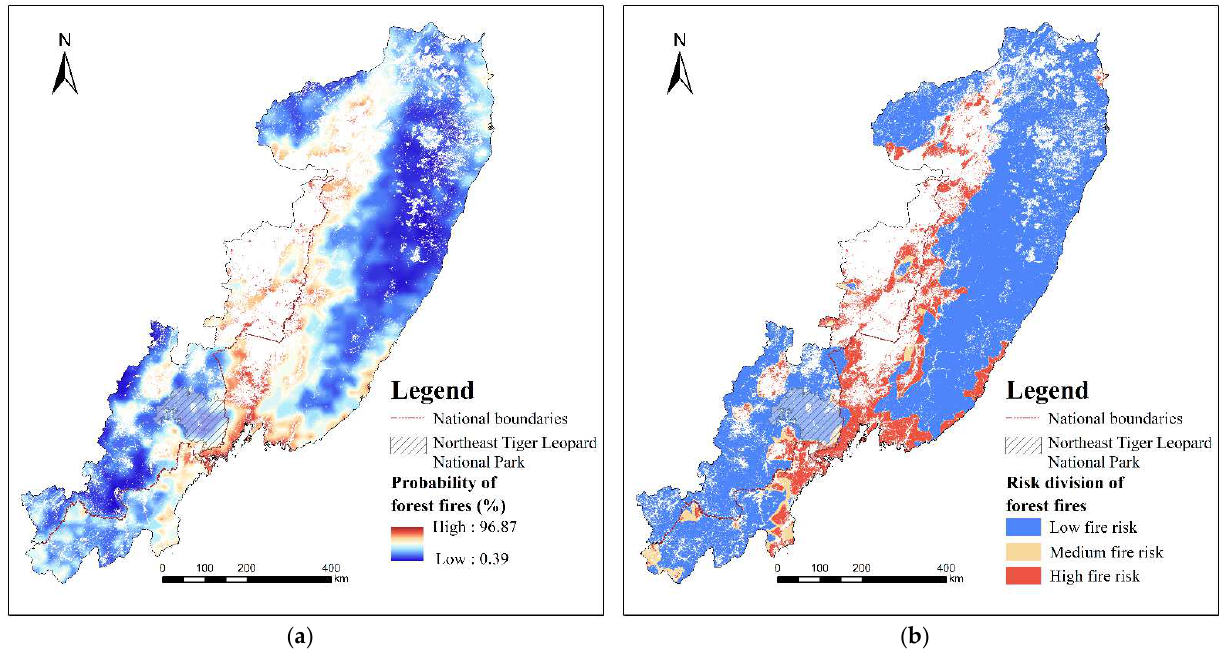
Figure 4. ( a ) Spatial distribution map of forest fire probability in the study area. ( b ) Fire risk level zoning map of the study